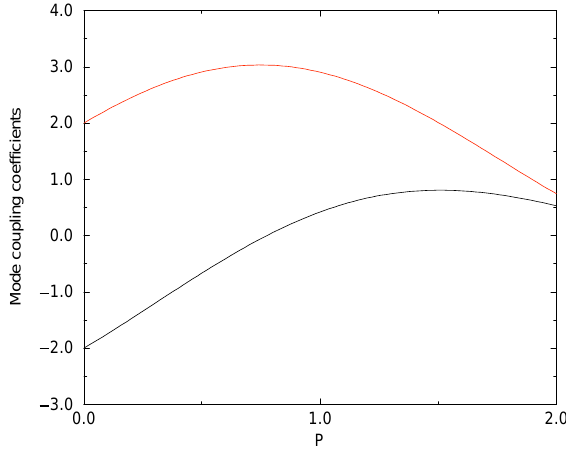
FIG. 1. (Color) Coefficients (cid:75) (cid:48)(cid:49) (upper) and (cid:75) (cid:49)(cid:48) (lower) versus the parameter (cid:80) [see Eq.